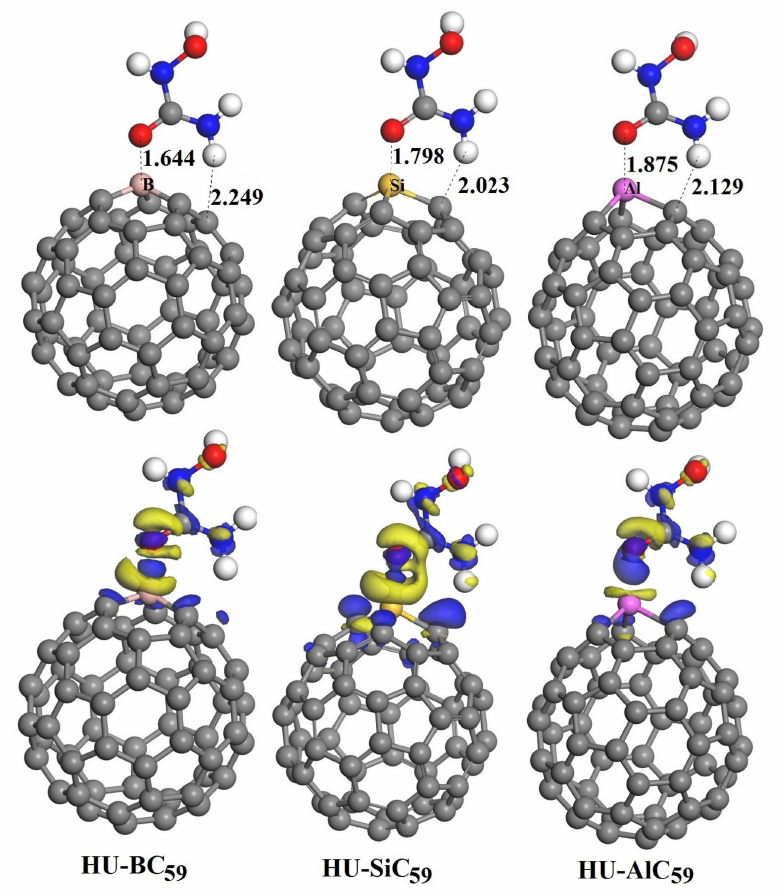
Figure 4. Optimized most stable structures and corresponding charge density difference (CDD) of HU-BC 59 , HU-SiC 59 , and HU-AlC 59 . All distances are in Angstrom. For comparison, the isosurface value is set to 0.03 a.u. (the same as Figure 2) for all. In the CDD plots, the blue and yellow colors correspond to the electron density gain and loss regions,